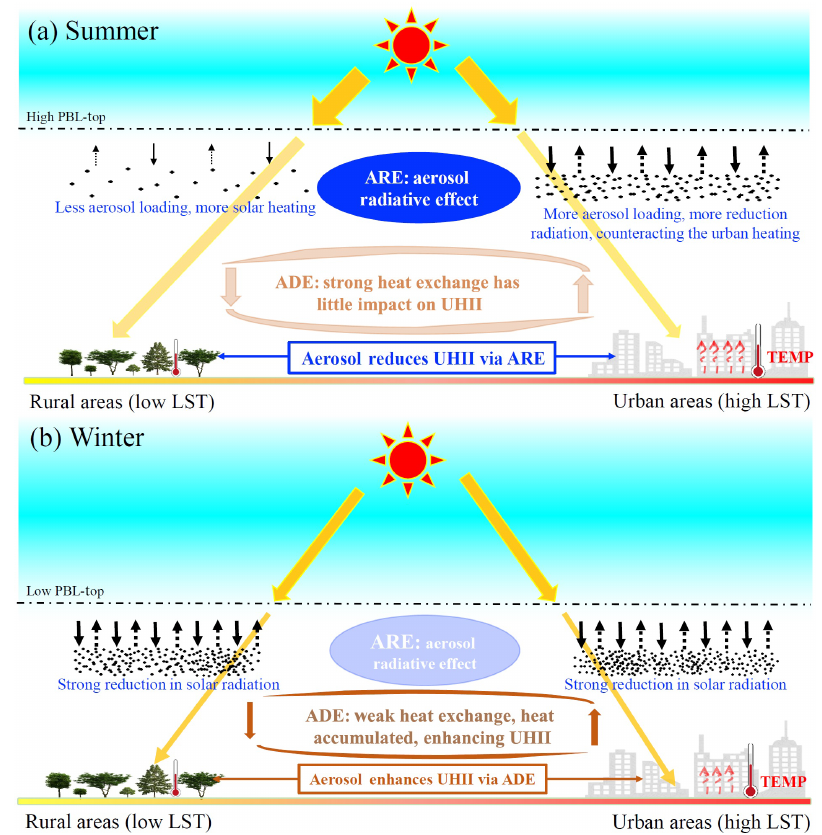
Figure 14. The impact of the ARE and the ADE on UHII in summer (a) and winter (b) by altering radiation (yellow arrows) and heat exchange (brown arrows) on thermal contrast between urban and rural areas. Note the difference in aerosol loading between summer and winter and between urban and rural